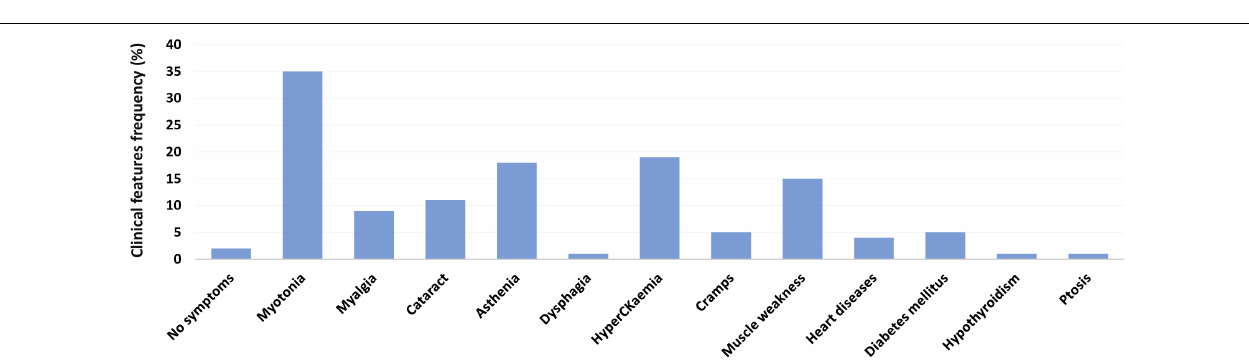
FIGURE 2 | Main clinical features of genetically confirmed DM2 patients ( n =